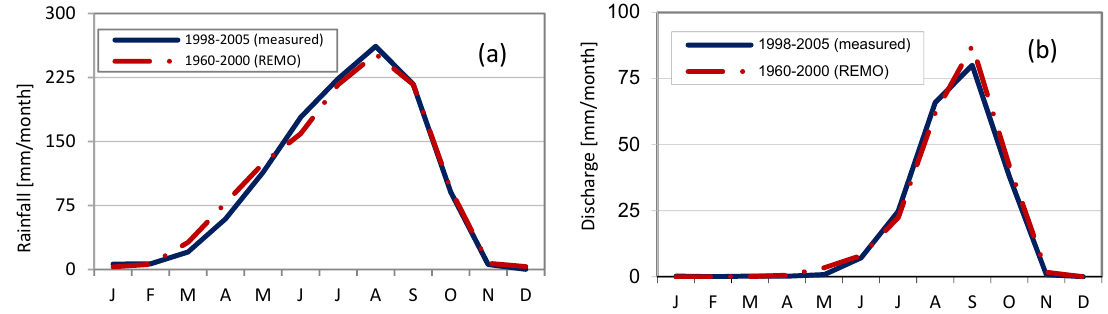
Figure 8. ( a ) Mean monthly rainfall from REMO output (period 1960–2000) compared with measurements (period 1998–2005) for the upper Ouémé catchment [15]; ( b ) Simulated mean monthly water discharge with SWAT using REMO output (period 1960–2000) compared measurements (period 1998–2005) for the upper Ouémé catchment [15].